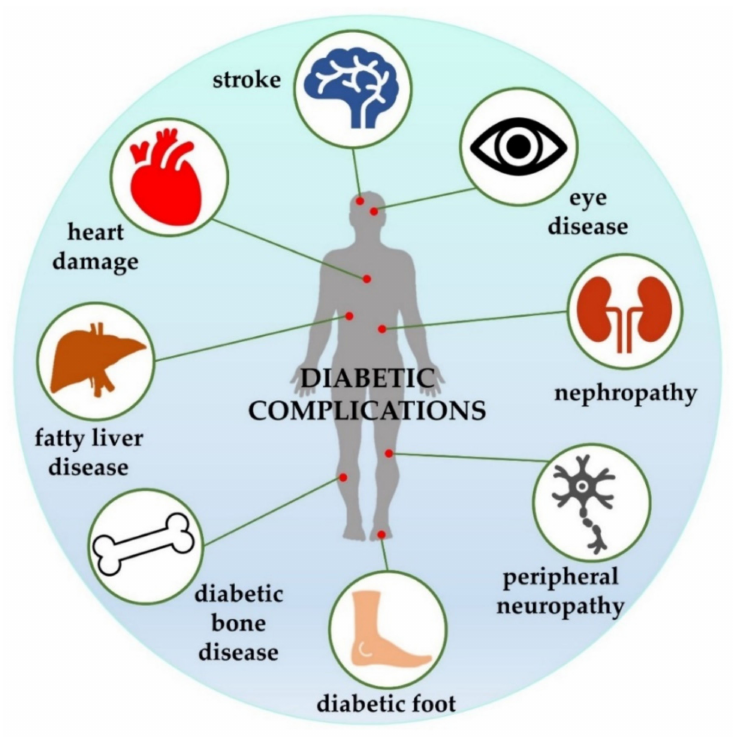
Figure 1. Selected secondary complications associated with